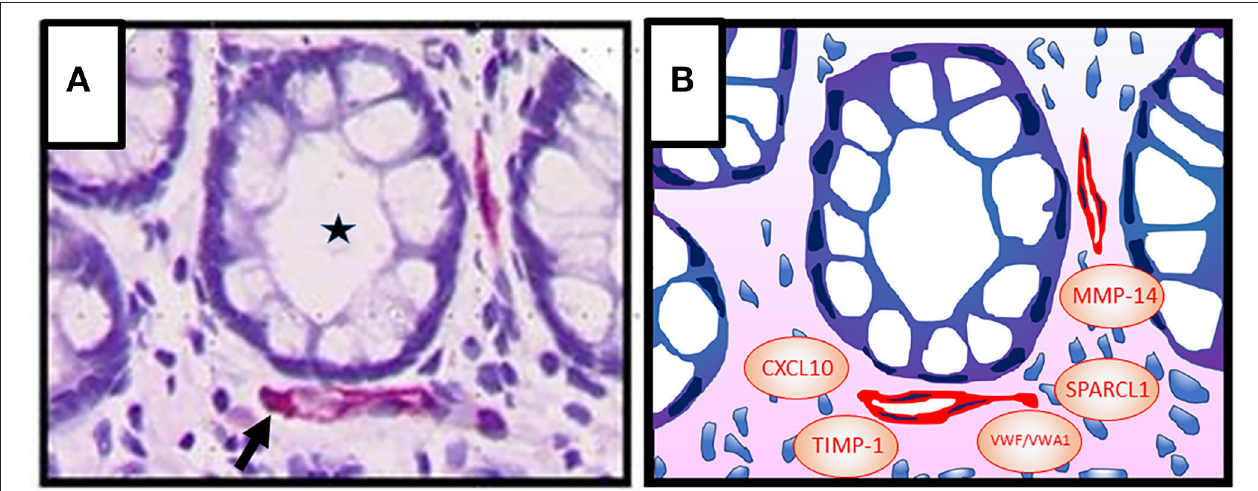
FIGURE 1 | (A) Colonic crypt (intestinal gland, asterisk) with vessels (red, arrow) in the lamina propria. Epithelial cells (1st barrier) and endothelial cells (2nd barrier) are directly adjacent, indicating active inter-barrier communication. Vascular endothelial cells were stained immunohistochemically using an anti-CD31 antibody. Cell nuclei (blue) were stained by haematoxylin. (B) Graphic presentation of (A) indicating possible factors that may be involved in angiocrine regulation of epithelial barrier functions in IBD [von Willebrand factor A domain containing 1 (VWA1), von Willebrand factor (VWF), matrix metalloproteinase (MMP)-14, tissue inhibitor of metalloproteinases (TIMP)-1, C-X-C motif chemokine ligand (CXCL) 10, secreted protein, acidic and rich in cysteine–like 1 (SPARCL1)].